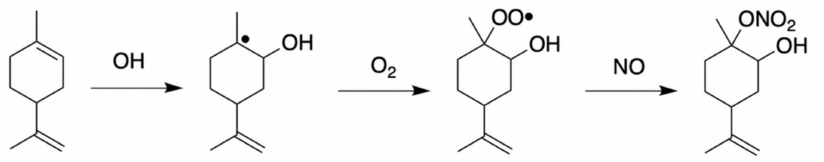
Figure 1. Representative gas phase oxidation reaction of